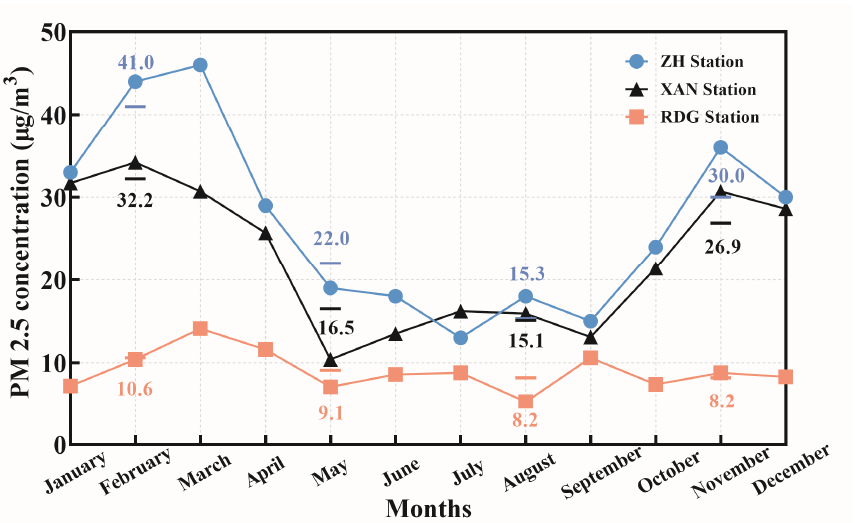
Figure 3. Mean monthly PM 2.5 concentrations at the ZH station, the XAN station, and the RDG station in 2021 (the short horizontal lines and digits beside them are the average concentrations corresponding to different seasons.).